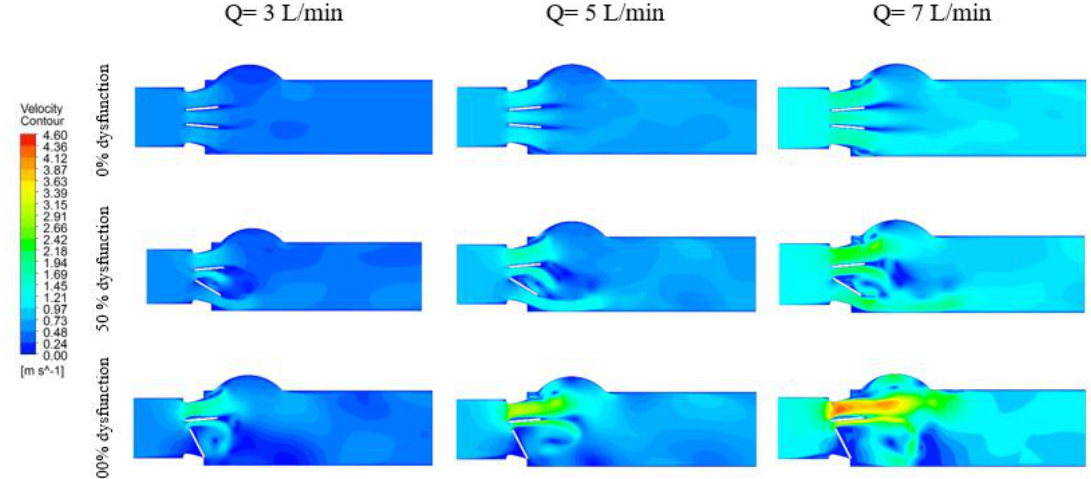
Figure 5. Velocity contours at peak systole (90 ms) for different percentages of BMHV dysfunction at three different cardiac outputs (3, 5 and 7 L/min) for 27 mm LVOT.